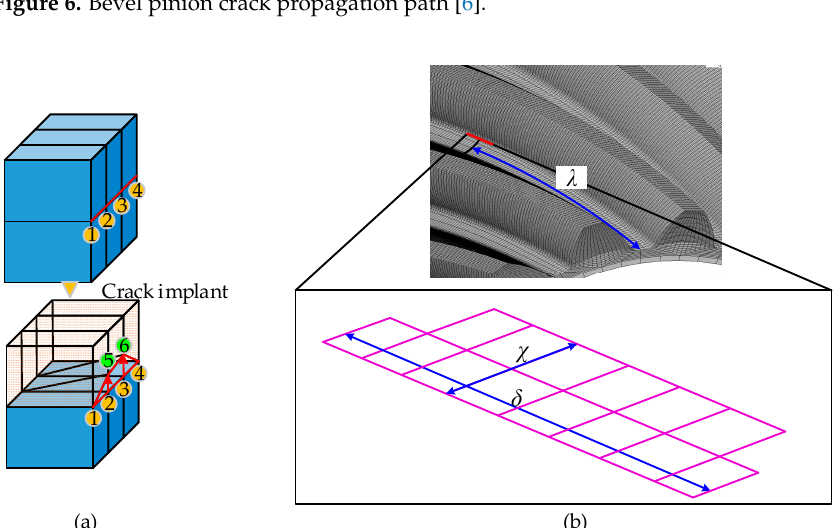
Figure 7. Node replacement method to generate crack section: ( a ) Node replacement example; ( b ) Crack characterization parameters.